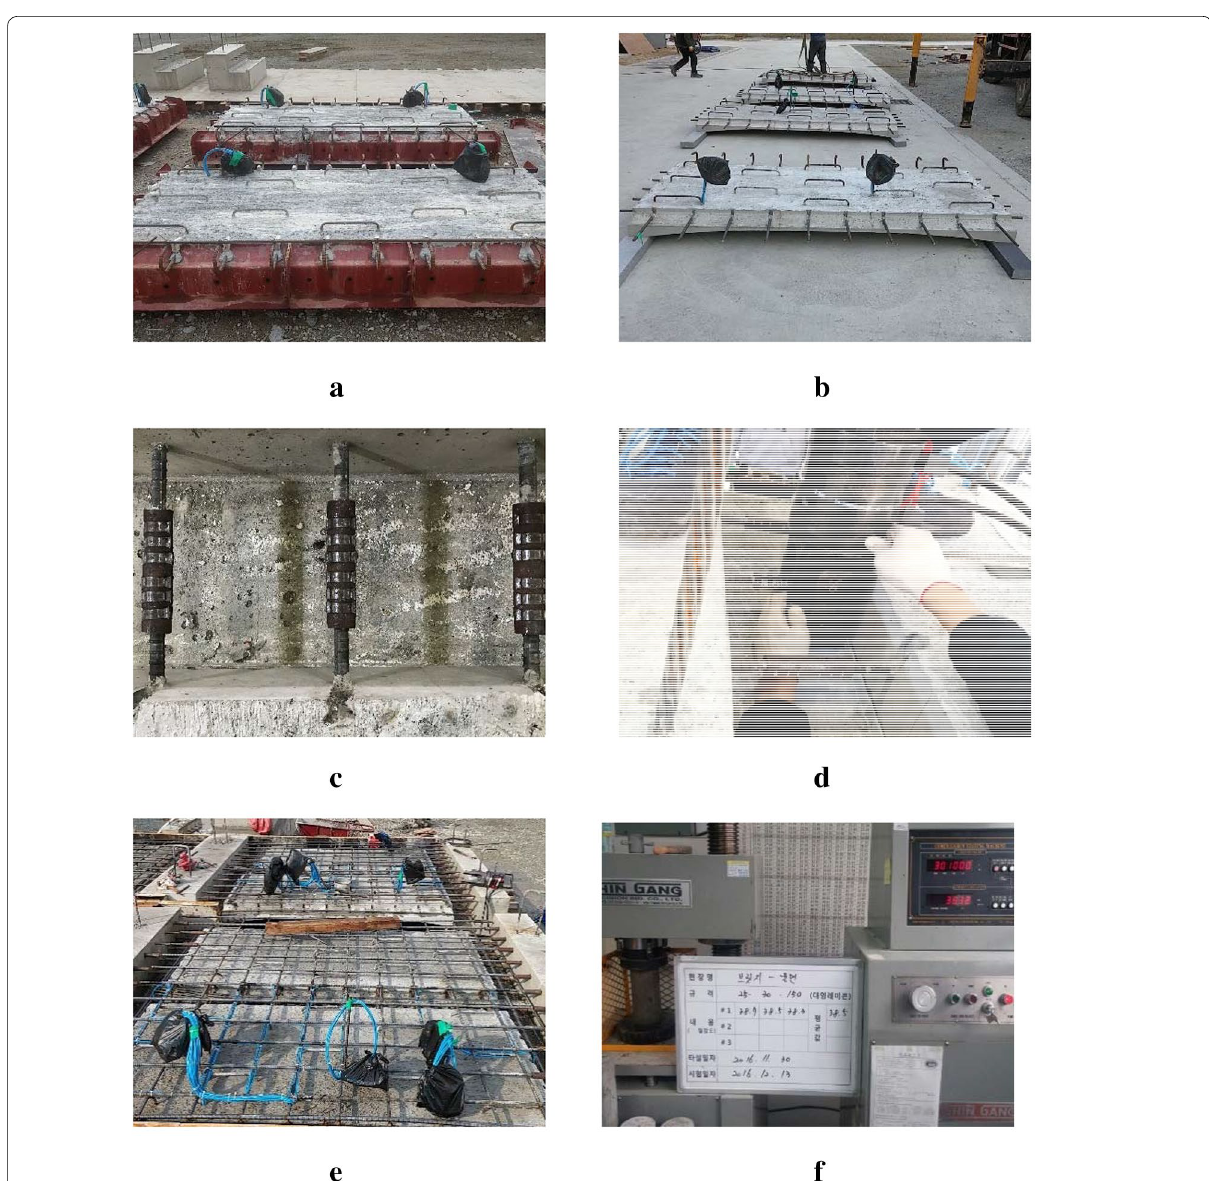
Fig. 2 Manufacture of RC arch deck (AD) and 2‑span RC arch deck specimen (BD). a Concrete casting and curing. b RC arch deck (AD). c Grip coupler. d Grip coupler setting. e Deck and rebar setting. f Concrete compressive strength